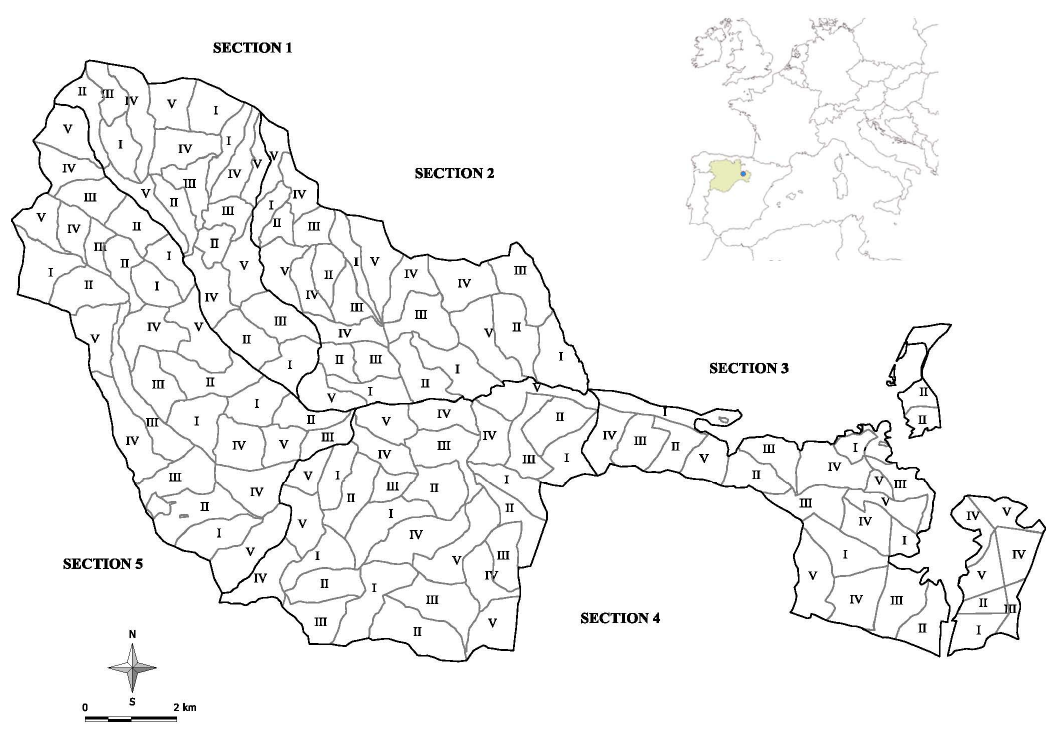
Figure 1. Location and description of forest management compartments in Pinar Grande Forest (Soria,